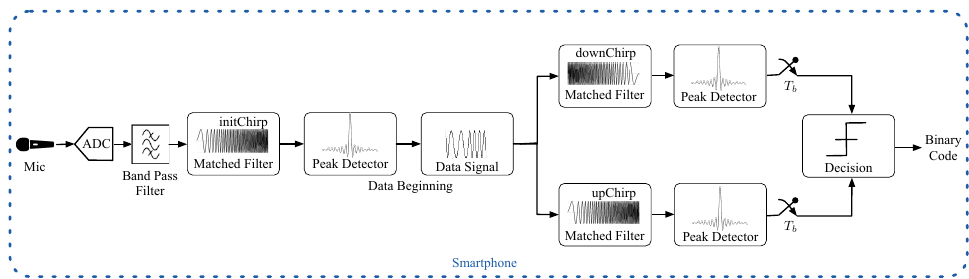
Figure 4. Diagram of the signal processing carried out in the